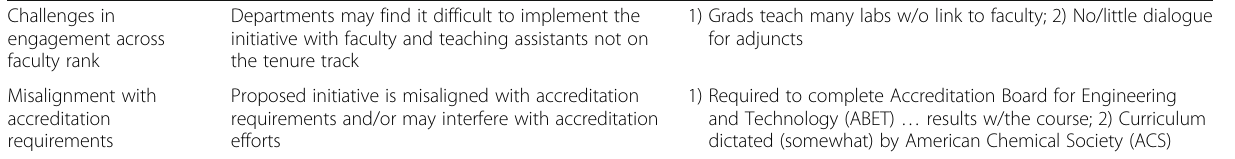
Table 2 Categories of faculty-identified barriers for STEM education change (Continued) Challenges in engagement